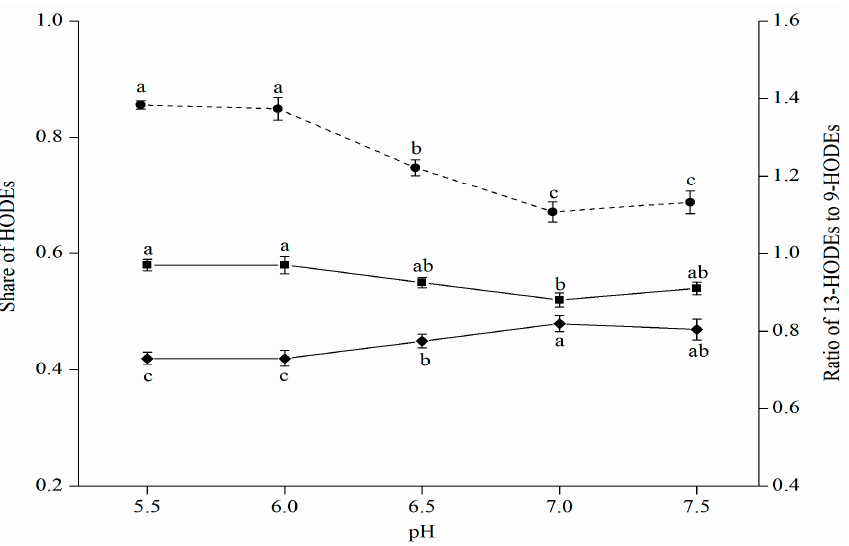
Figure 2. Variations of shares of 13-HODEs (— ■ —), 9-HODEs (— ◆ —) and ratio of 13-HODEs to 9-HODEs (-- ● --) with pH increasing from 5.5 to 7.5. Values with different letters in the same line are significantly different ( p < 0.05).